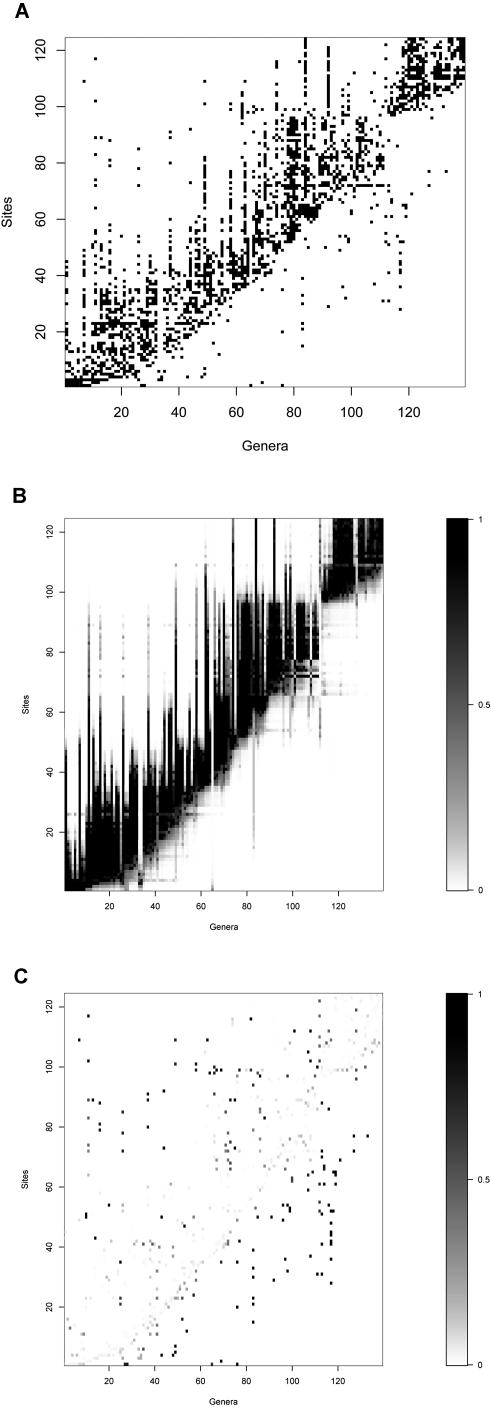
The Data Matrix for the Dataset with nt = 10 and ns = 10The sites have been ordered by E{π(n)} and the genera by E{am} (top). Probability that genus m is alive on site n in the dataset specified by nt = 10 and ns = 10 (middle). Probability that one is false (bottom). Black color denotes probability of one, and white probability of zero.